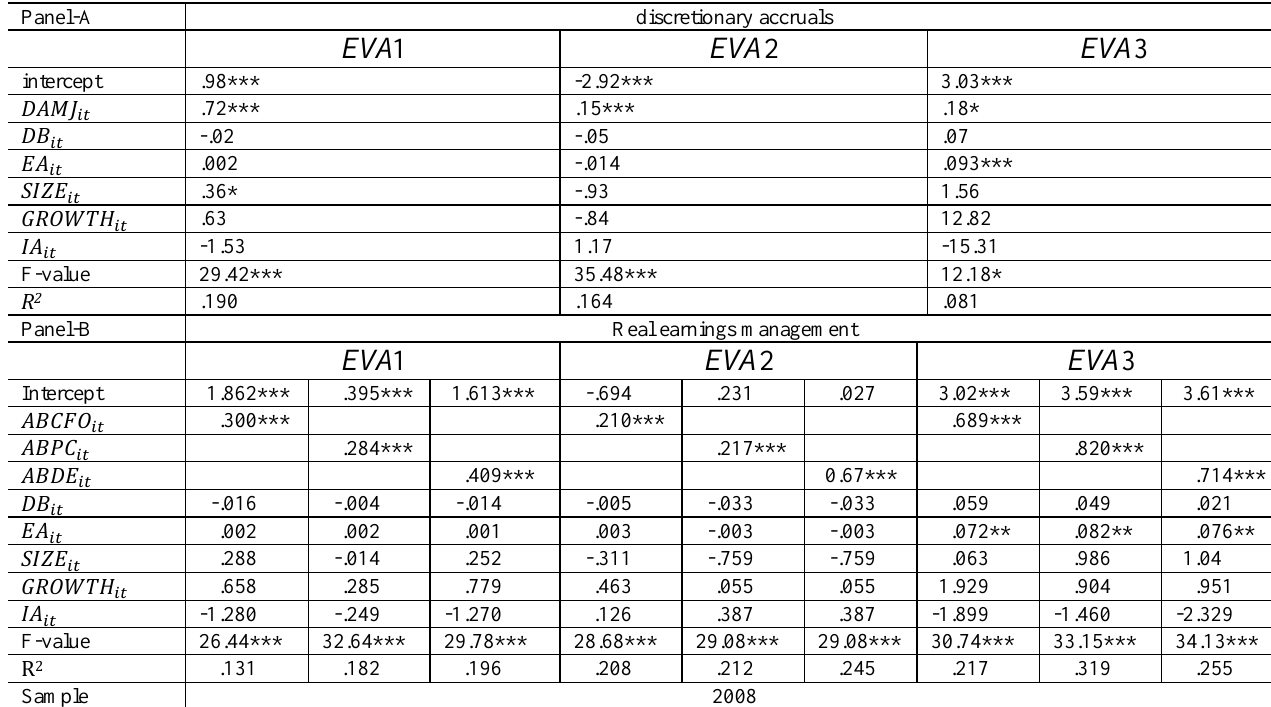
Table 3: Regressions of earnings management with economic value added (EVA) for Association of Southeast Asian Nations (ASEAN) Panel-A